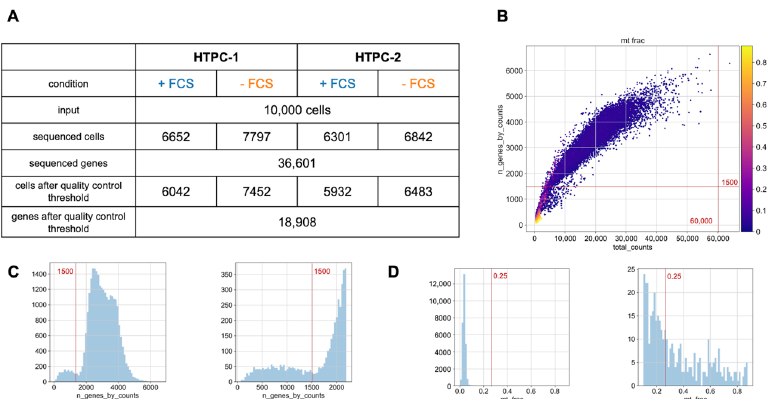
Figure A1. ( A ): Summary of cell numbers of both HTPCs and the amounts of detected transcripts. ( B – D ): Information about quality control of single-cell RNA-seq data. Thresholds are displayed in red lines. ( B ) Number of detected genes according to count depth per cell. The color code indicates the fraction of mitochondrial counts. Quality thresholds were set to a minimum of 1500 genes and a maximum cell depth of 60,000. ( C ) Number of genes per cell. The right graph shows counts in less than 2500 genes. ( D ) The minimum mitochondrial fraction was set to 0.25.